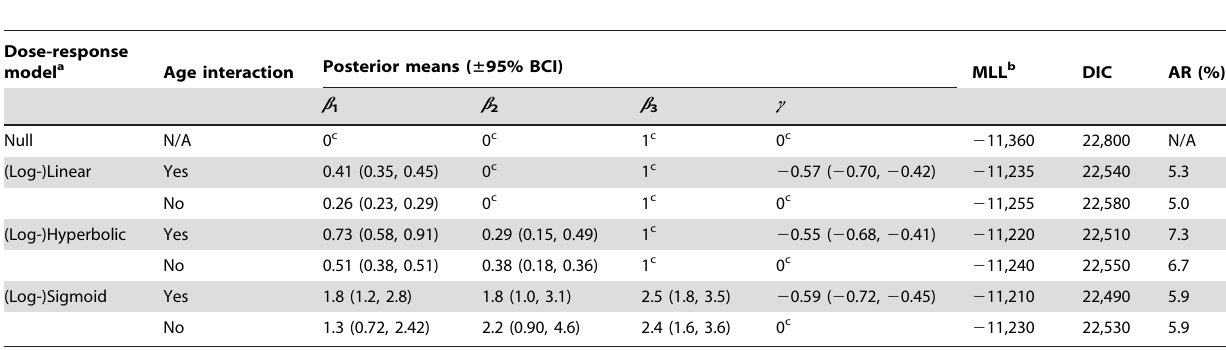
Table 3. Parameter estimates, maximum log-likelihood, deviance information criterion and mortality risk attributable to Onchocerca volvulus